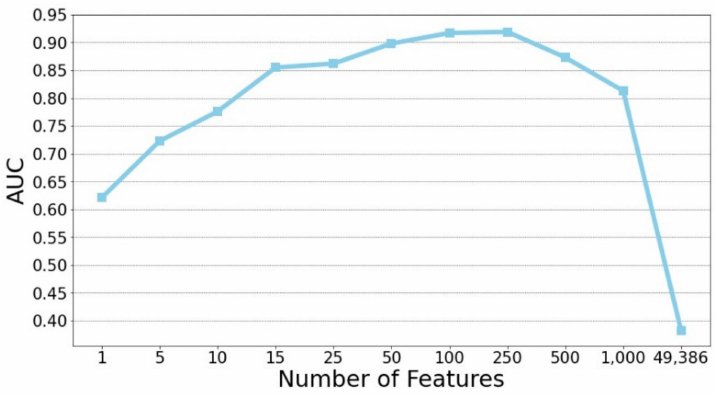
Figure 2. Rank-based feature selection of predictive probes for predicting stable MCI